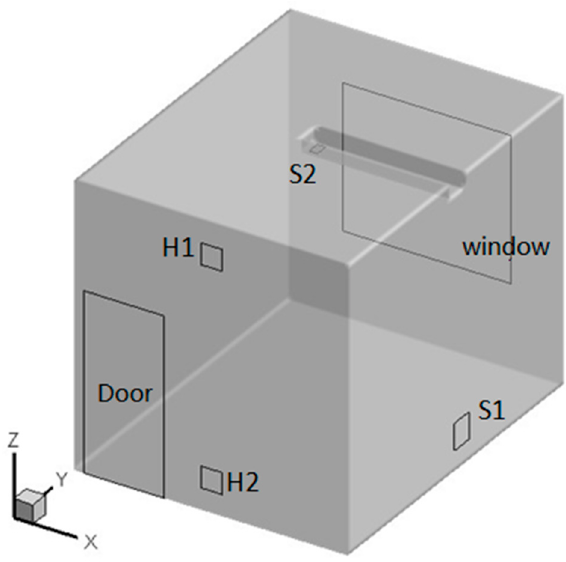
Figure 1. Schematic diagram of the test chamber.